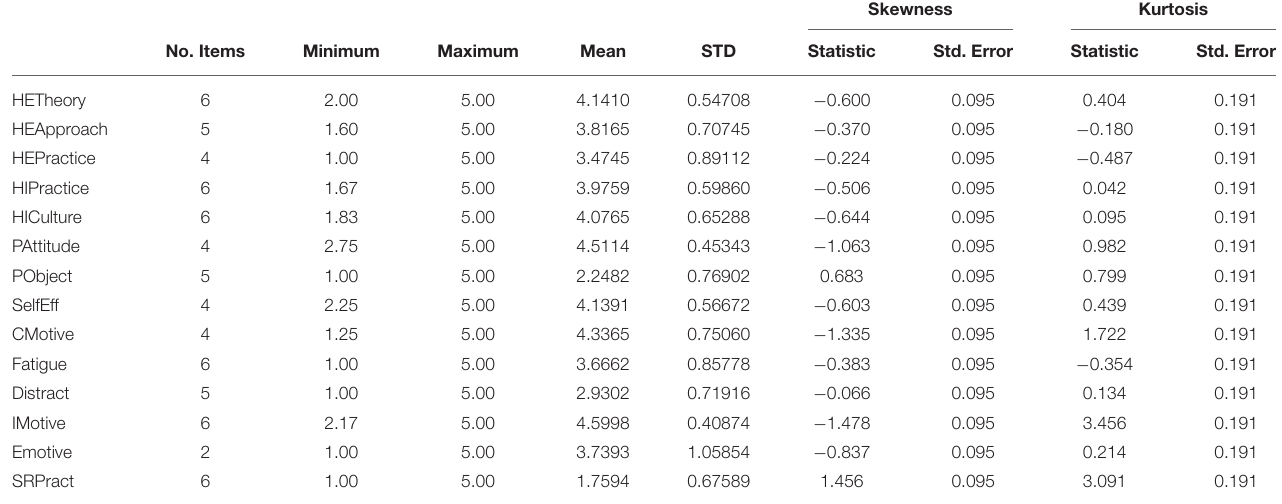
TABLE 6 | Total items per factor, mean, and